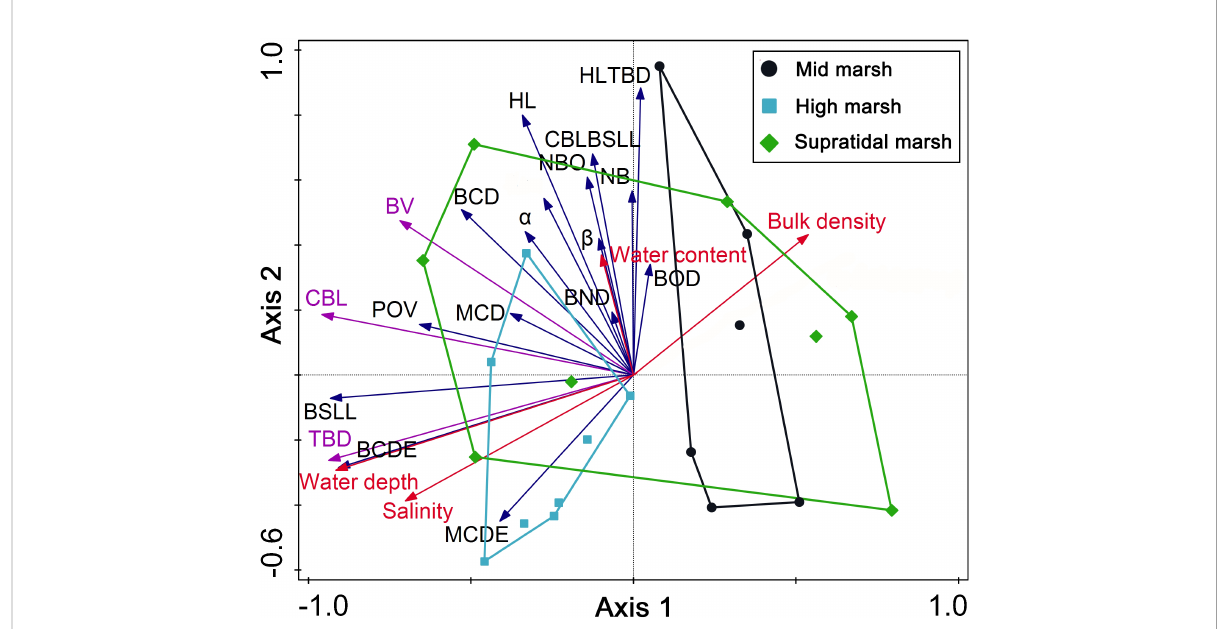
FIGURE 8 Relationships between abiotic factors and crab burrow morphological characteristics using PCA. Codes for morphological characteristics are shown in Table 1. Abiotic factors are represented by red arrows. The morphological characteristics are represented by black arrows. The key morphology indicators for estimating crab excavation are represented by purple arrows. The region surrounded by colorful lines indicate a cluster of sampling sites into the three salt marsh zones.